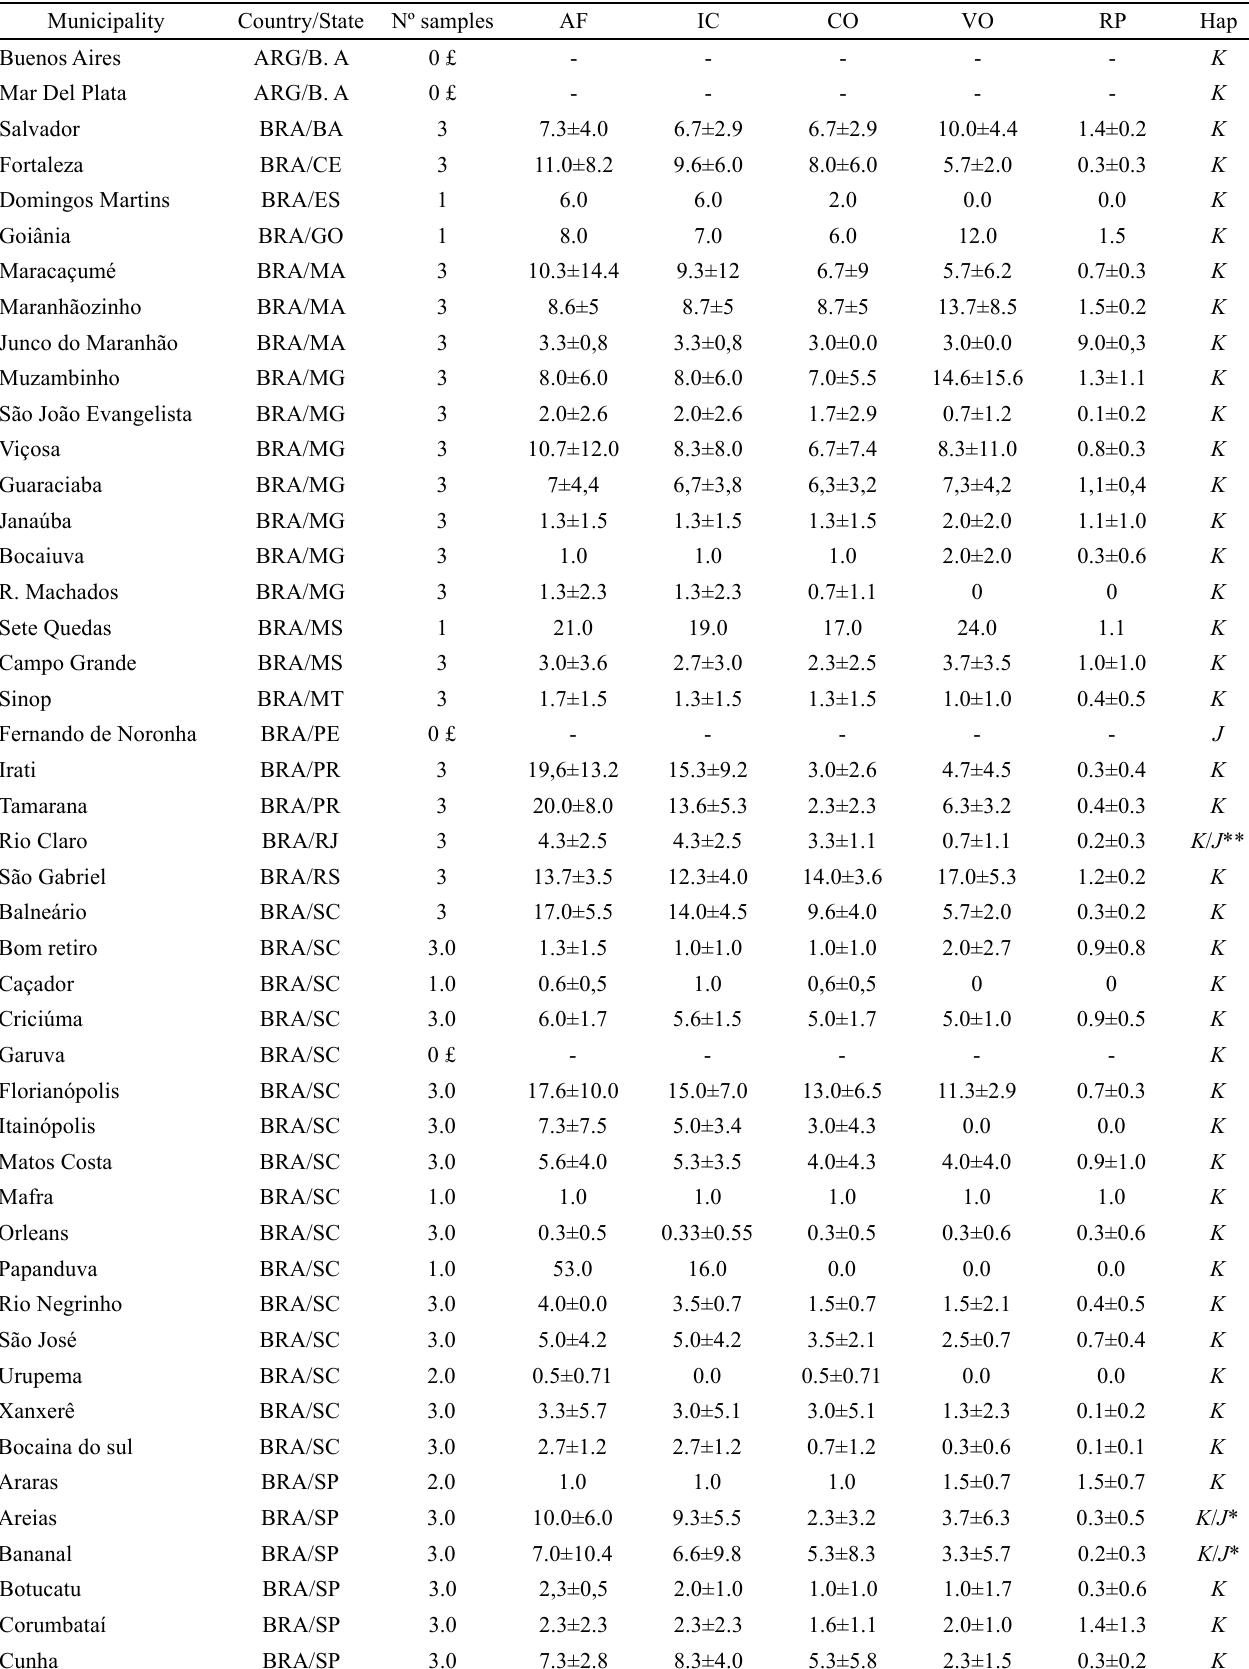
Table 1 . Reproductive and genetic parameters of worker brood cells infested with Varroa destructor (mean ± sd): AF – adult female mite (total), IC – infested brood cells (%), CO – brood cells infested with offspring (%), VO – viable offspring (total), RP – reproductive potential (total) and Hap –